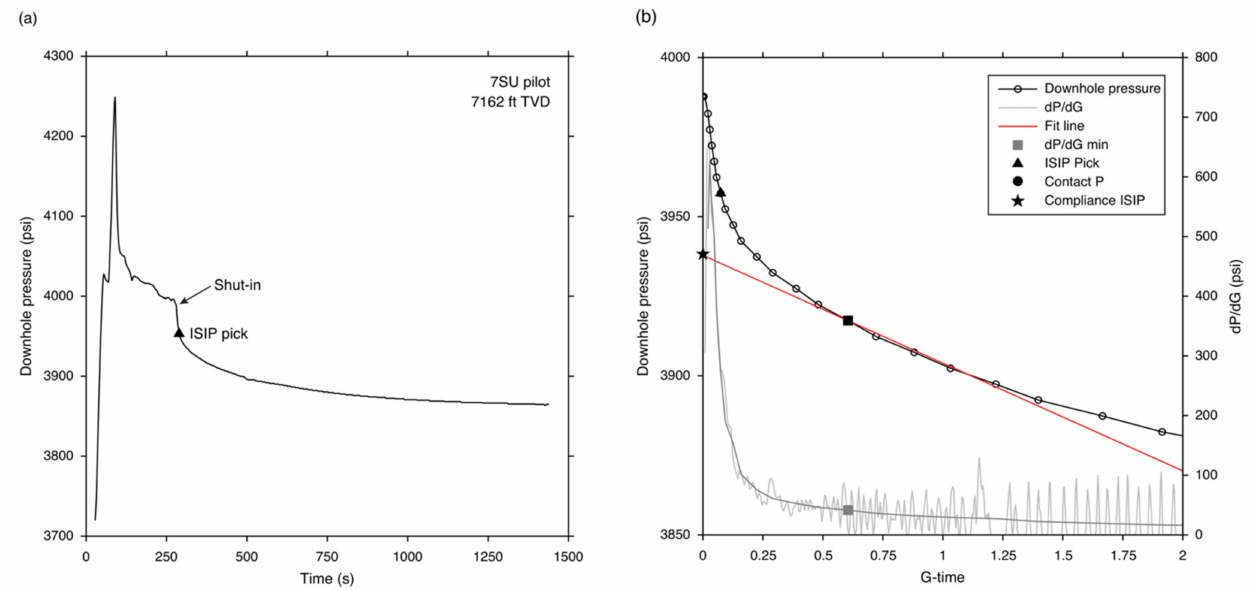
Figure A1. DFIT test at 7162 ft TVD in the 7SU pilot well. ( a ) Downhole pressure record before and after shut in. Triangle symbol represents the value of the instantaneous shut in pressure (ISIP) picked visually. ( b ) Downhole pressure after shut in plotted as a function of G-time. Star symbol represents the ISIP determined from the compliance method